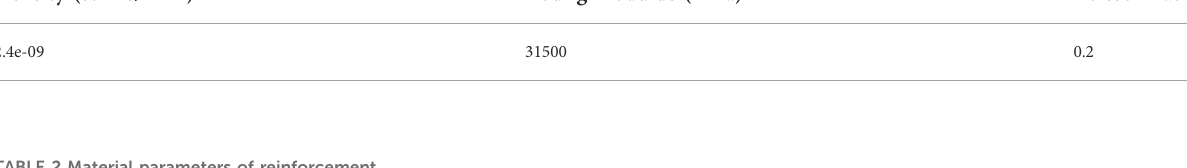
TABLE 1 Material parameters of concrete.